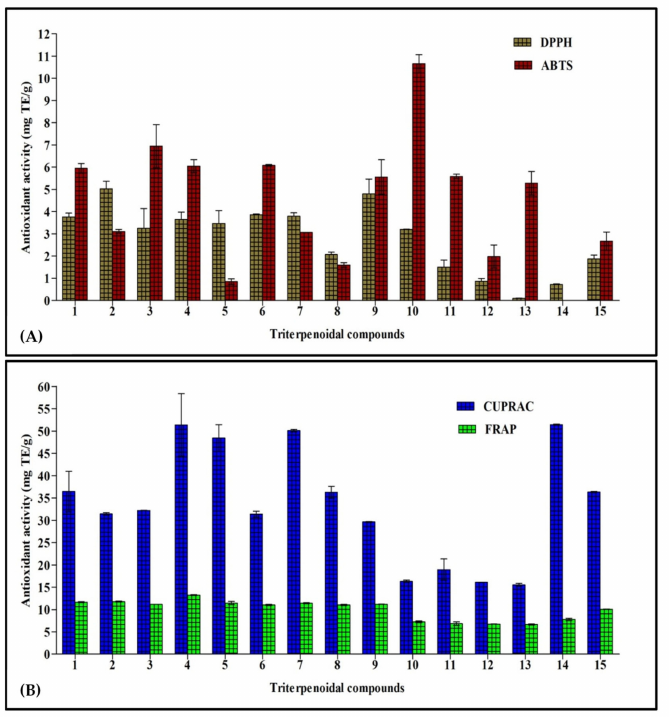
Figure 2. Antioxidant activity of fifteen triterpenes, employing DPPH and ABTS ( A ), and CUPRAC and FRAP ( B ) expressed in mg TE/g. Values are reported as mean ± S.D.; TE: Trolox